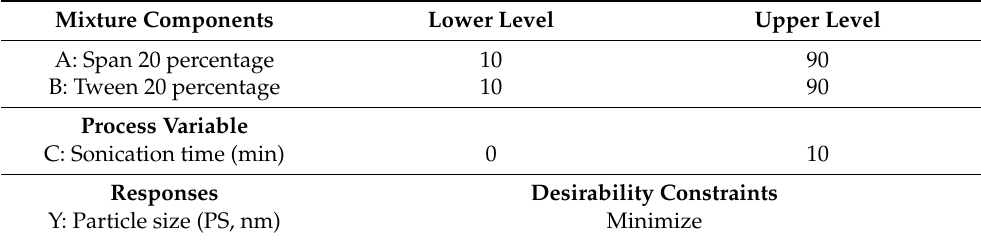
Table 1. Ranges of mixture components and process variables and the desired constraints of the response variables for the CMPV design.